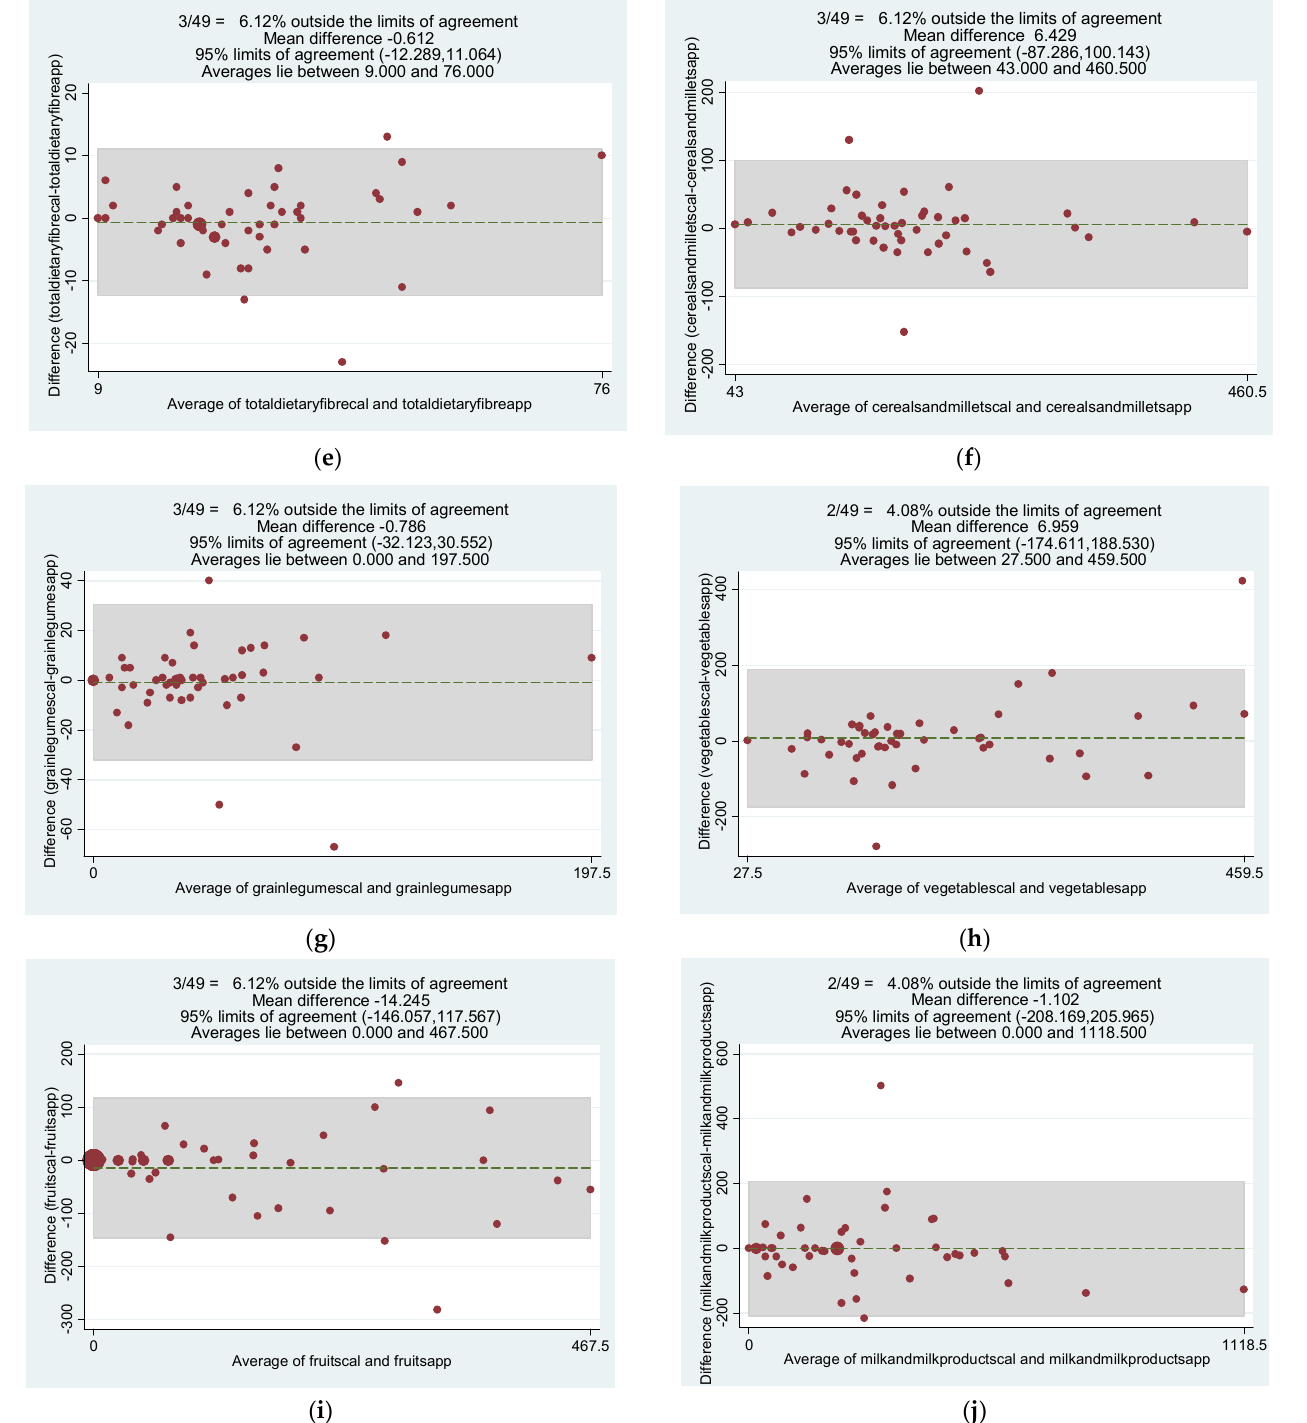
Figure 3. Bland–Altmann Plots showing the level of agreement between two methods of diet data collection (1) 24 ‐ h diet recall and (2) IBD NutriCare mobile app at 95% CI. ( a ) Protein; ( b ) fat; ( c ) carbohydrates; ( d ) energy; ( e ) total dietary fiber; ( f ) cereals and millets; ( g ) grains and legumes; ( h ) vegetables; ( i ) fruits; ( j ) milk/milk products.